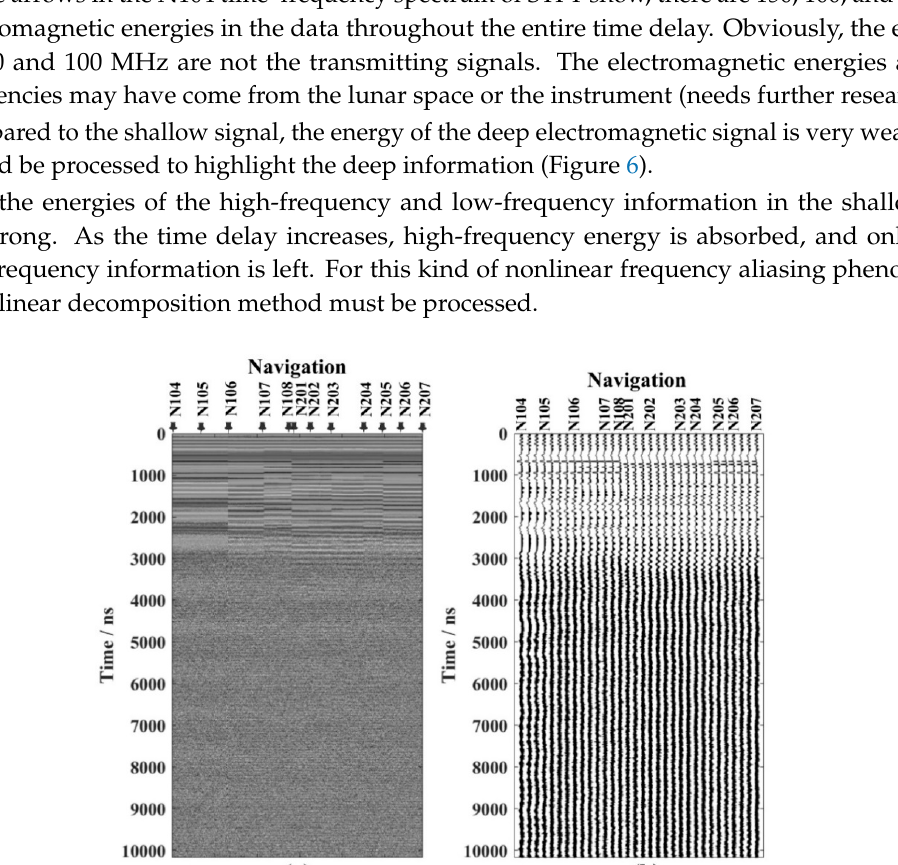
Figure 5. Time–frequency spectrum of ( a ) N104, ( b ) N106, ( c ) N202, and ( d ) N206 traces.